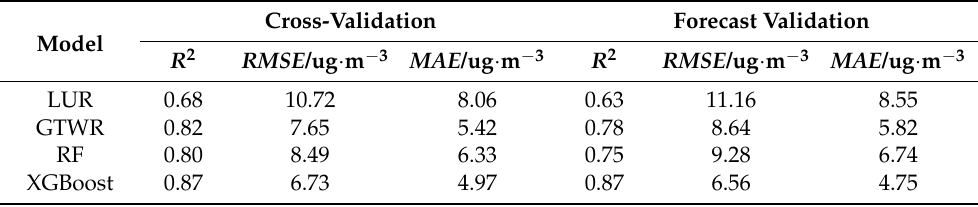
Table 3. A single model that considers only natural environmental factors. Model